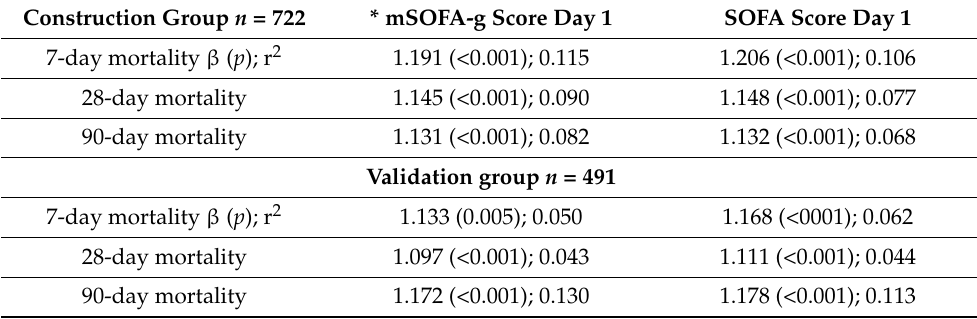
Table 4. The mSOFA-g_score and SOFA score prediction power of